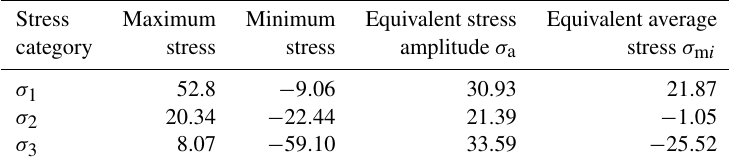
Table 1. Calculation data of three principal stresses (MPa).